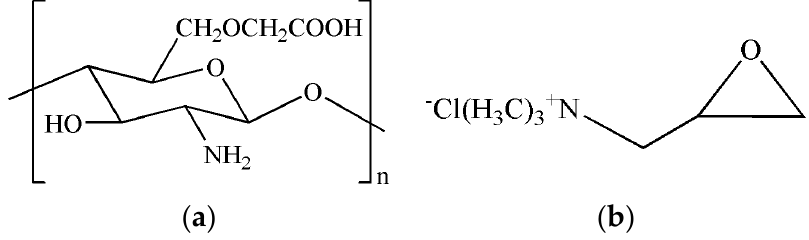
Figure 1. Chemical structure of ( a ) carboxymethyl chitosan (CMC) and ( b ) 2,3-epoxypropyltrimethyl ammonium chloride (ETA).